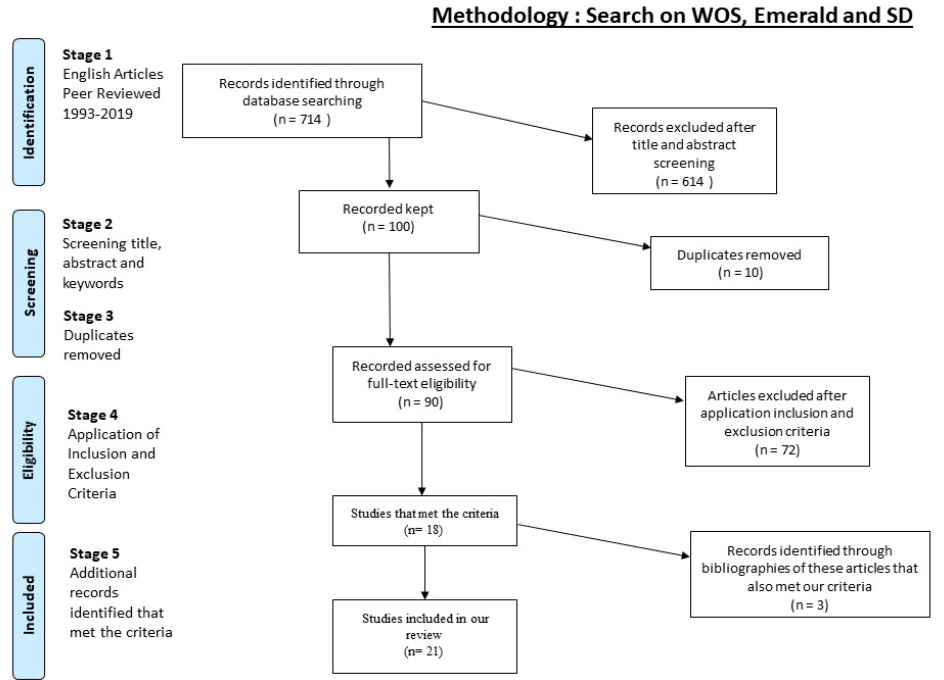
Figure 1. Literature review methodology.